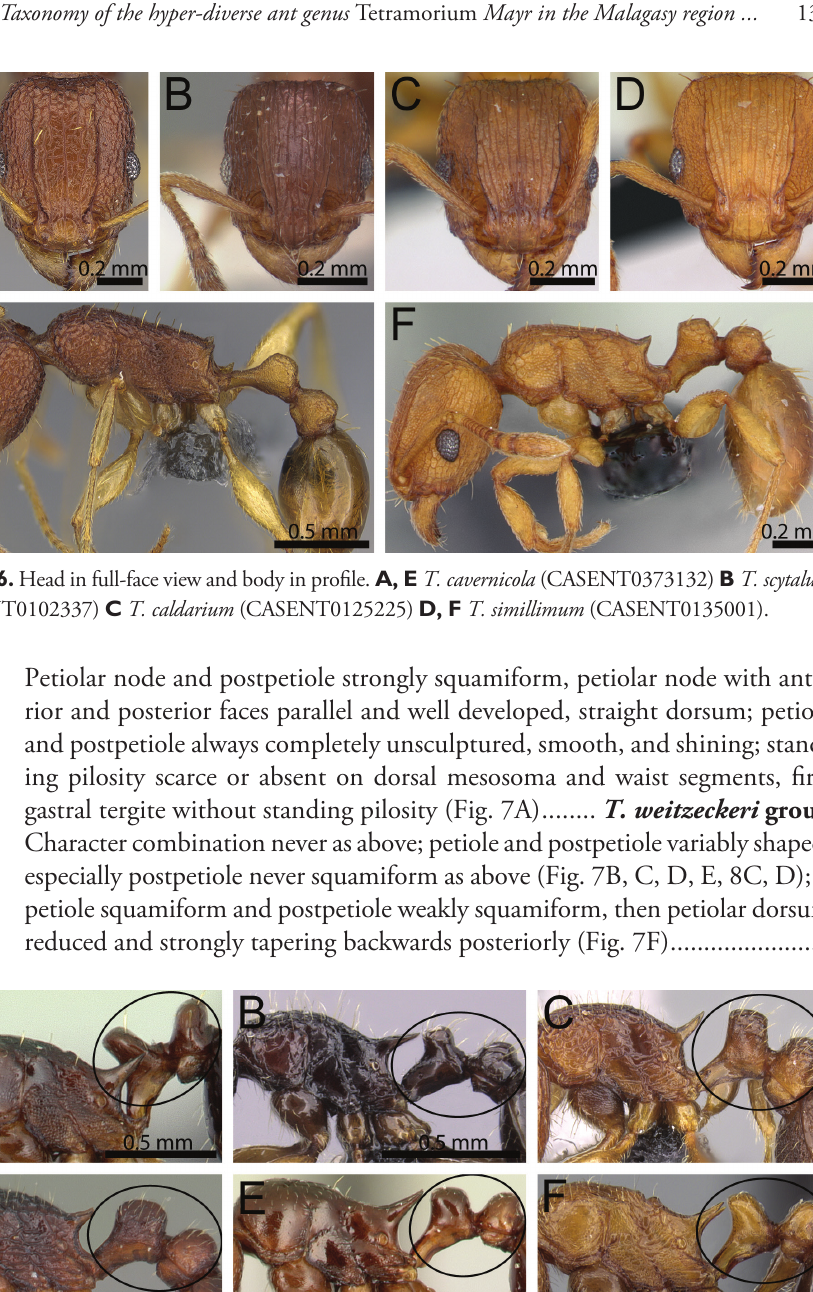
Figure 7. Mesosoma and waist segments in profile (waist segments within black ellipses). A T. humbloti (CASENT0134851) B T. ambatovy (CASENT0124721) C T. gollum (CASENT0074974) D T. qua- sirum (CASENT0102353) E T. malagasy (CASENT0449550) F T. bessonii